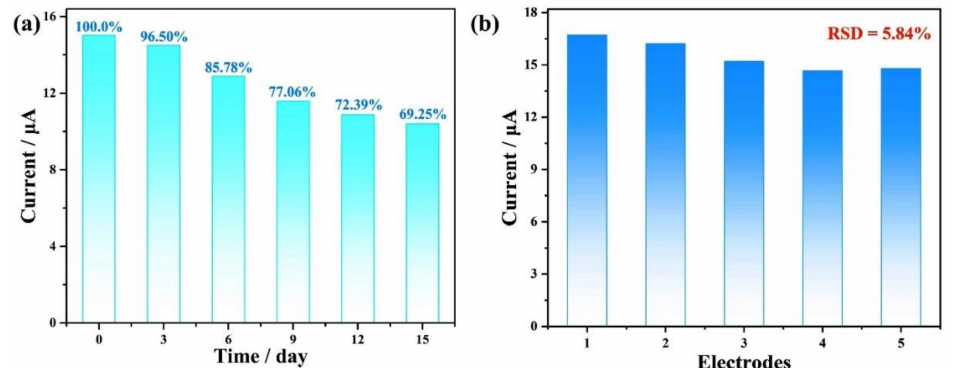
Figure 8. ( a ) The histogram of current vs. storage time of Cu@Co–MOF/GCE sensing 1.0 mM Glu in 0.01 M NaOH with Cu@Co–MOF/GCE stored at 4 ◦ C for 3–15 days; ( b ) the histogram of five parallel